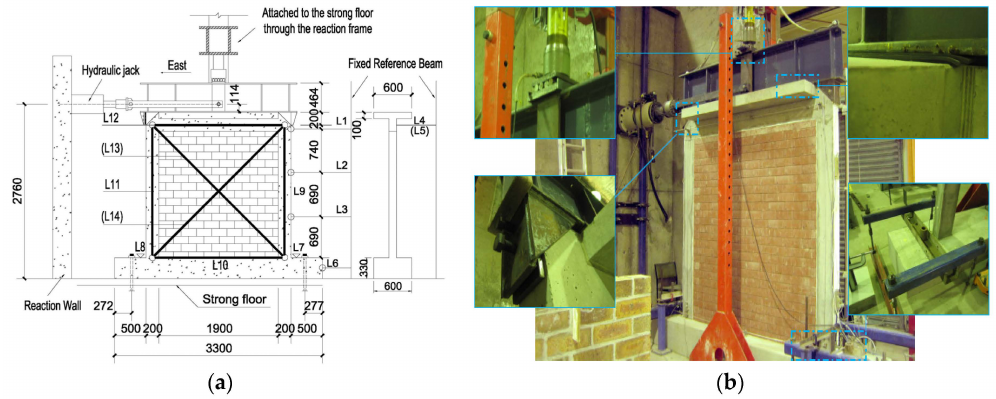
Figure 5. Experimental setup: ( a ) Test setup (unit: mm); ( b ) Photos. L, LVDT.